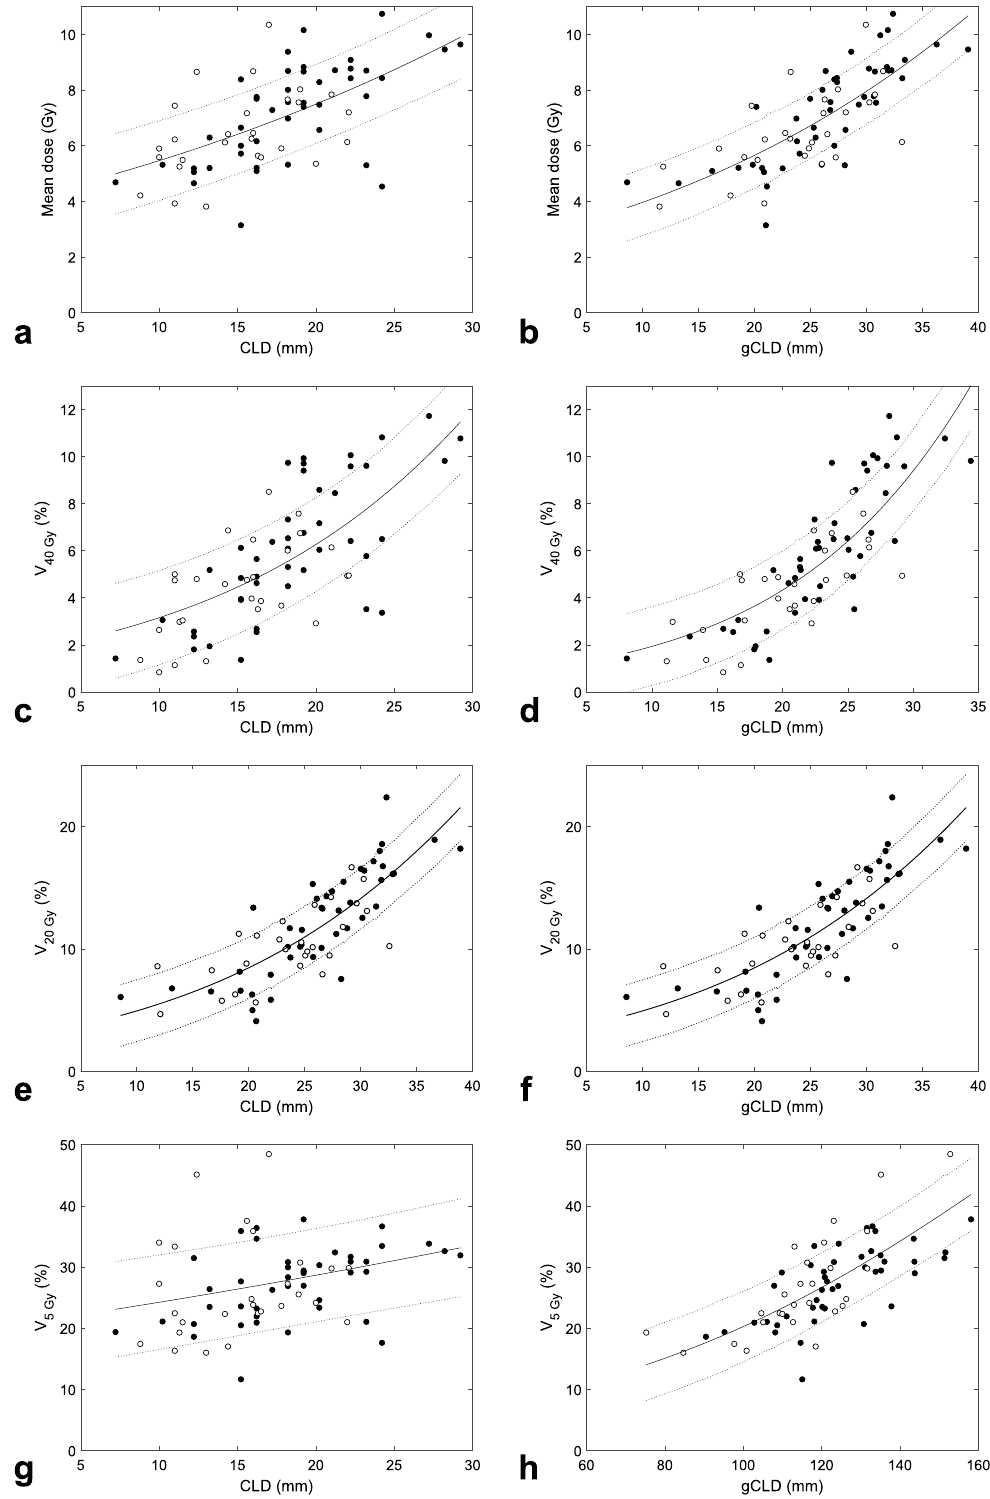
Figure 4. Linking dose-volume metrics to anatomic features: data for individual patients with left-sided breast cancer irradiated with 3DCRT without wedges in centres 1 and 2 (filled and empty circles) and the corresponding logit GLM fits (solid lines) with their prediction uncertainties (dotted lines). Mean doses to the ipsilateral lung ( a , b ) and volume fractions exposed to 40, 20 or 5 Gy ( c – h ) can be related to central lung distance (CLD, a , c , e , g ) or to a linear combination of 2–3 anatomic features ( b , d , f , h ) listed in Table 2. To facilitate comparison with CLD-based models, the given linear combinations are presented in terms of ‘generalized CLD’, given by gCLD = Σ i (β i /Σ j β j )X i ; for CLD-based models, gCLD = CLD, hence its name. For mean dose to the ipsilateral lung ( b ) gCLD = 0.17 MLW + 0.53 CLD + 0.30 MHD, for V 40 Gy ( d ) gCLD = 0.12 MLW + 0.58 CLD + 0.30 MHD, for V 20 Gy ( f ) gCLD = 0.16 MLW + 0.62 CLD + 0.22 MHD, while for V 5 Gy ( h ) gCLD = 0.59 MLW + 0.41 BW. The prediction uncertainties (Supplementary Material) are shown as the prediction plus/minus one standard deviation, i.e. the given dose-volume metric should be found within this prediction interval for 68% of new